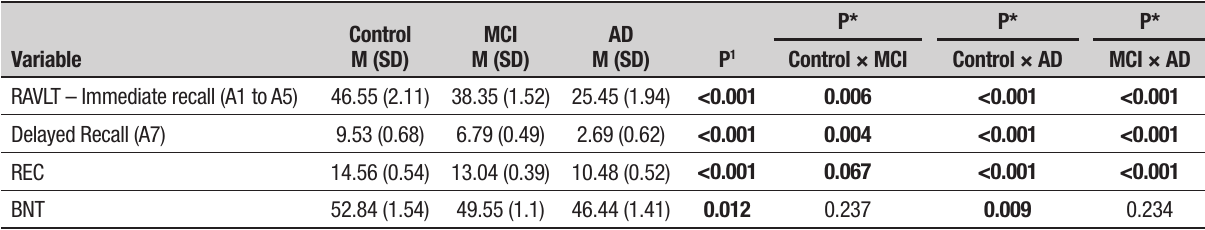
Table 2. Estimated mean values and standard errors of neuropsychological scales, adjusted for sociodemographic characteristics and result of comparisons, by group.